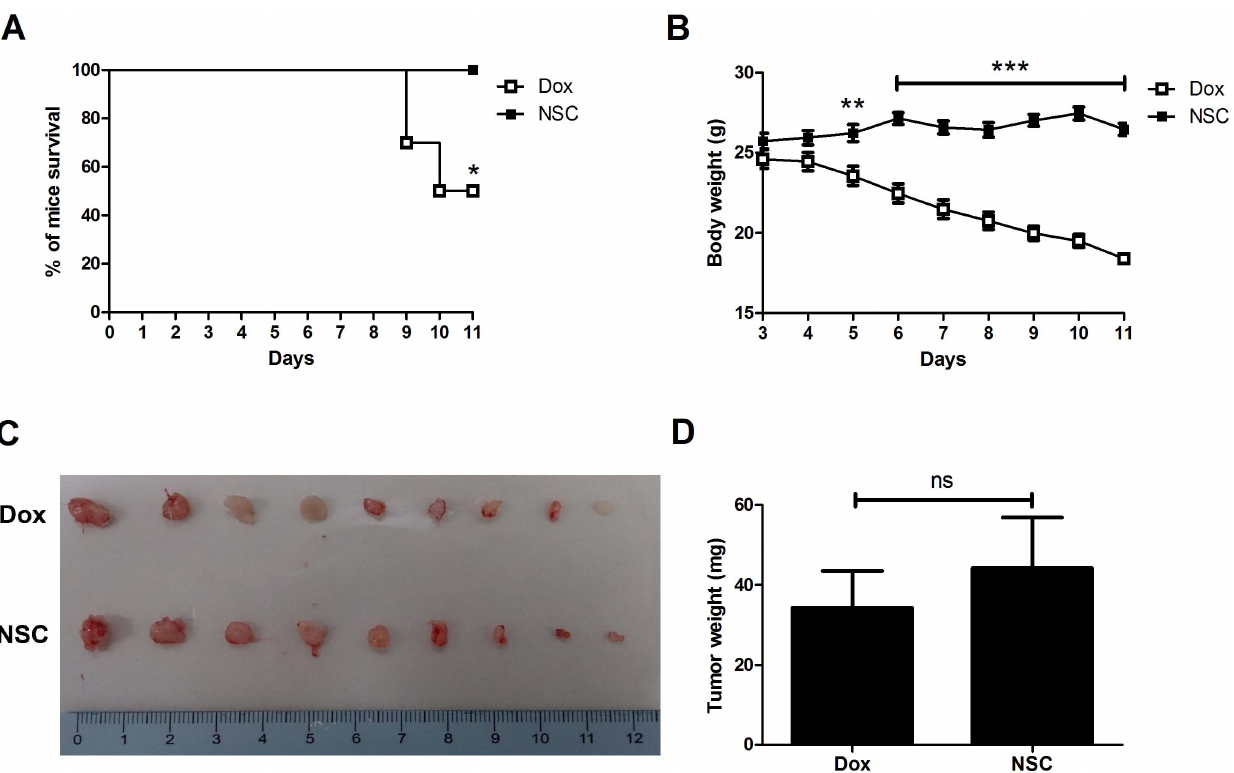
Figure 9. Comparisons of the safety and the anti-tumor efficiency between NSC745885 and doxorubicin. The cancer cell implanted NOD/SCID mice were administered with NSC745885 (NSC, 2 mg/kg/d) or doxorubicin (Dox, 2 mg/kg/d) on day 3. (A) The survival rates between NSC745885 and doxorubicin treated mice were assessed. There are no experimental mice were dead under NSC745885 treatment by day 11. By contrast, 50% of doxorubicin treated mice were dead (n=10). (B) The body weights of doxorubicin treated mice were significant decreased when compared to NSC745885-treated group from day 3 to day 11 after the beginning of drug treatment. (C) SAS cells were inoculated into NOD/SCID mcie, and the treatments of doxorubicin or NSC745885 were started at day 3 after cell inoculation. Engrafted tumors were isolated on day 11 after SAS cell inoculation (n=9). (D) There are no significant differences between NSC745885-treated and doxorubicin-treated groups (n=9).